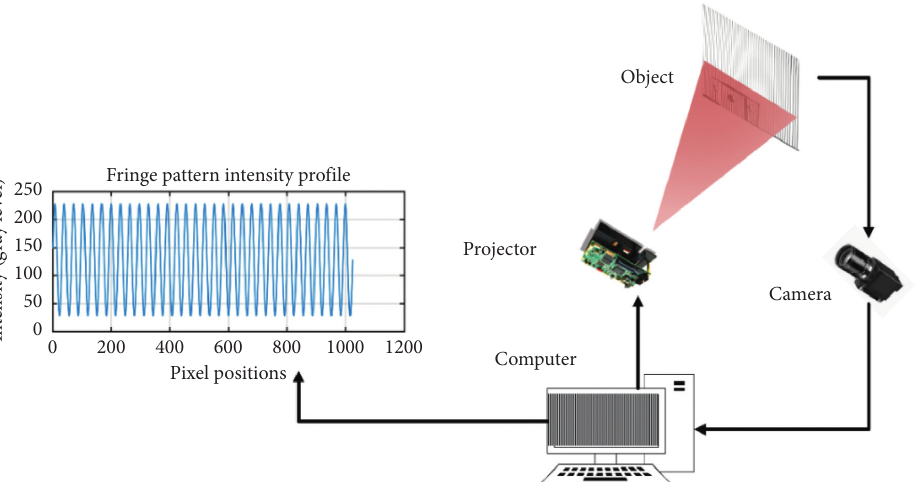
Figure 3: Schematic diagram of the adaptive digital fringe projection method.